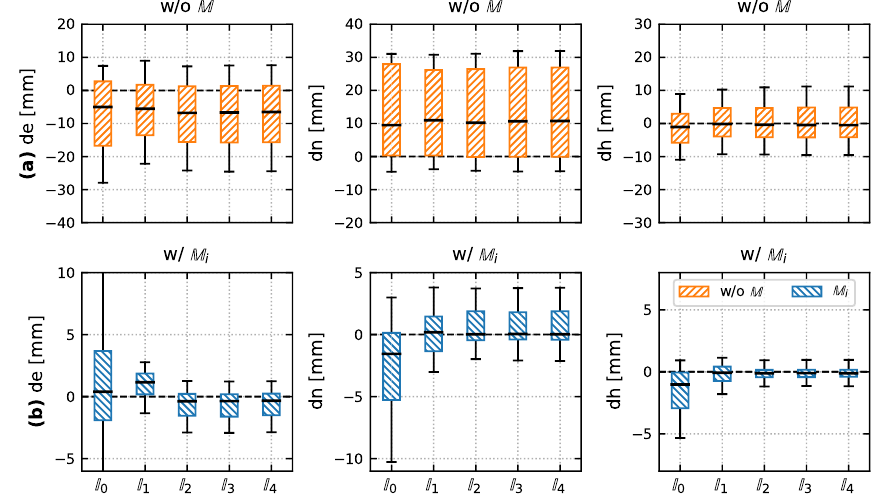
Figure 9. Tilt Compensation Evaluation ( n = 75) for different IMU sensor models I 0 to I 4 . ( a ) Without Mounting. ( b ) With the corresponding mounting M i for I i